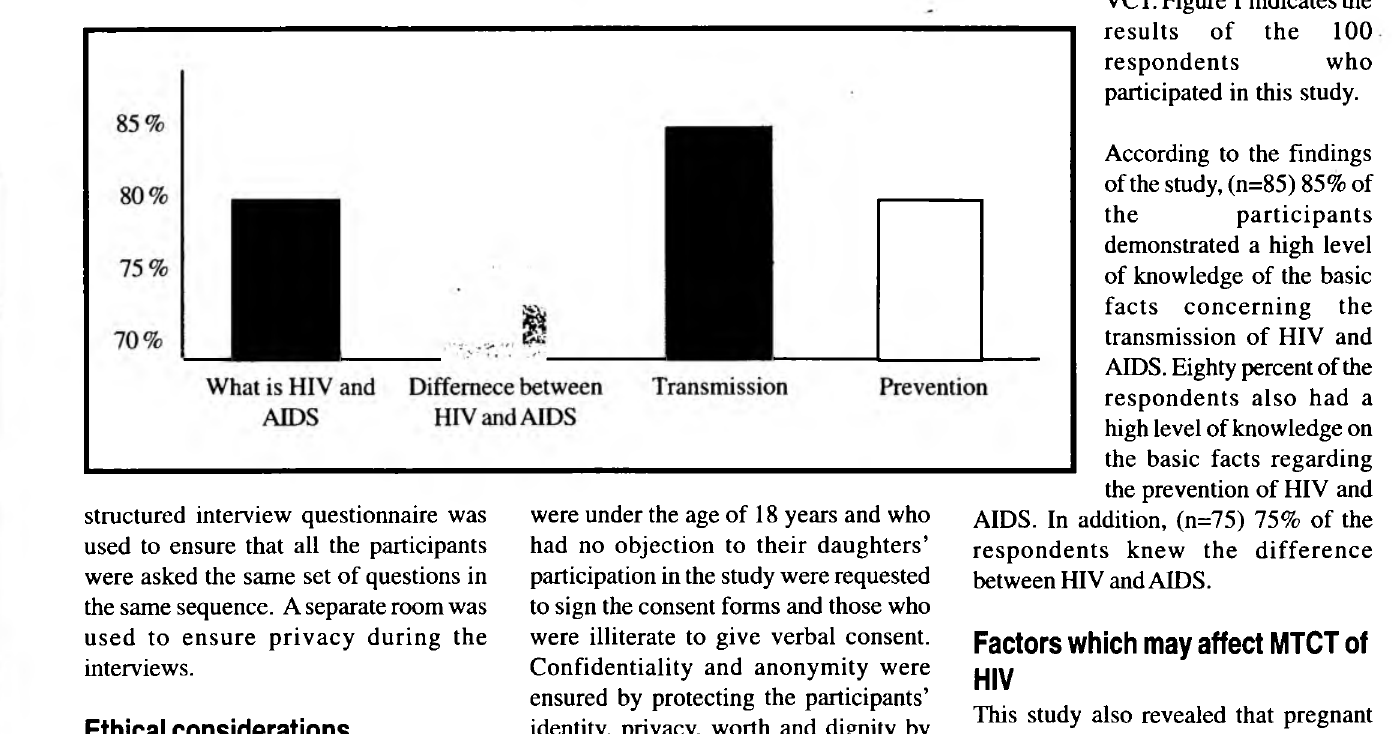
VCT. Figure 1 indicates the